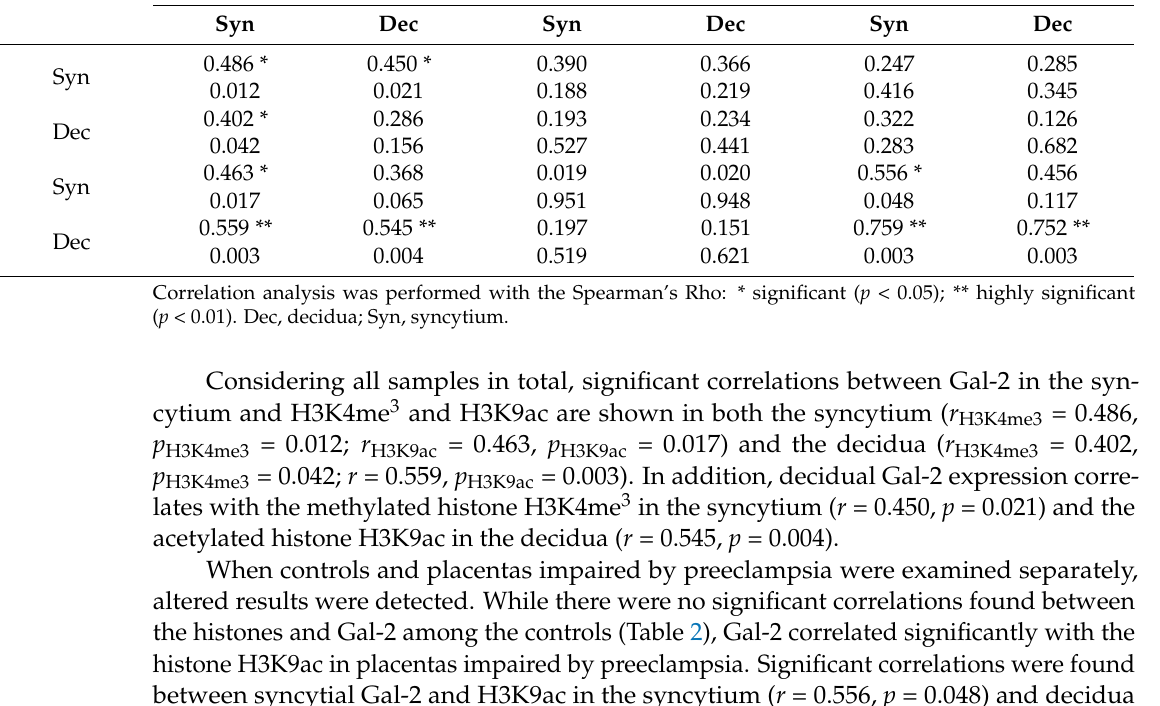
Table 2. Correlations of the histones with other proteins. The upper value is the correlation coefficient r; the second value is the p -value. Gal-2 in All Placentas Gal-2 Only in Controls Gal-2 Only in PE Syn Dec Syn Dec Syn